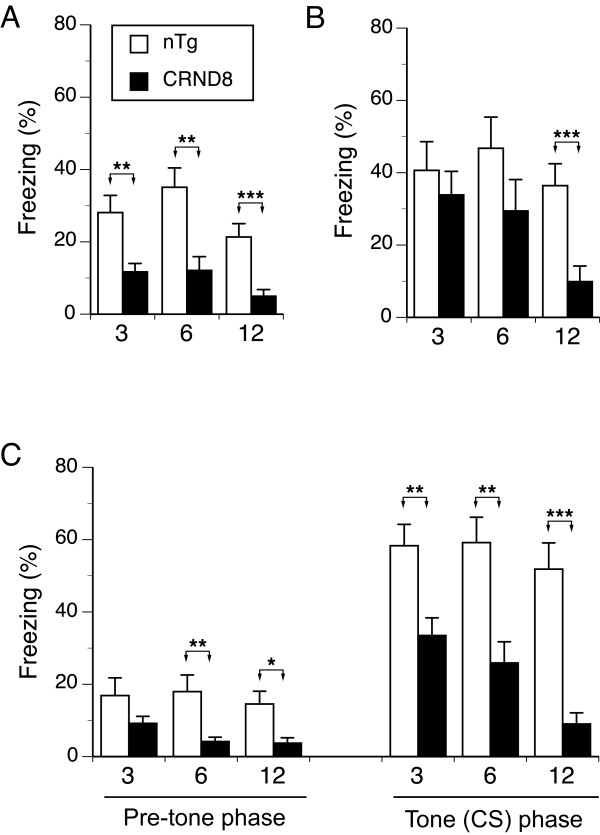
Mean (± SEM) percent of freezing by CRND8 mice and their non-transgenic (nTg) littermates at three, six, and 12 months of age. (A) CRND8 mice showed significantly lower rates of freezing as compared to nTg mice immediately following the presentation of a foot shock during training (P < 0.001 - genotype effect). (B) Overall, the context memory of CRND8 mice was impaired as compared to control nTg mice (P < 0.01 - genotype effect). No differences in context memory were found between nTg and Tg mice at three and six months, but at 12-months the CRND8 mice were significantly impaired (post-hoc Bonferroni t-test). (C) CRND8 mice froze significantly less than nTg mice during the pre-tone (left panel) and the tone (right panel) phases of the test. The CRND8 mice showed significant impairment in tone fear memory at each age of testing (right panel). Three, six, 12 on the abscissae refer to the age of testing. * P < 0.02, ** P < 0.01, *** P < 0.001.